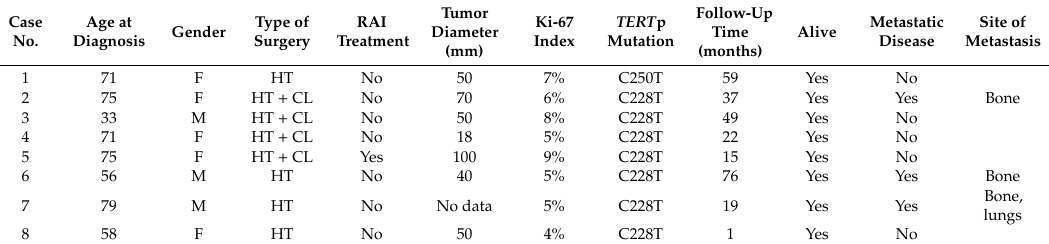
Table 2. Clinical characteristics of TERT -promoter-mutated FT-UMP